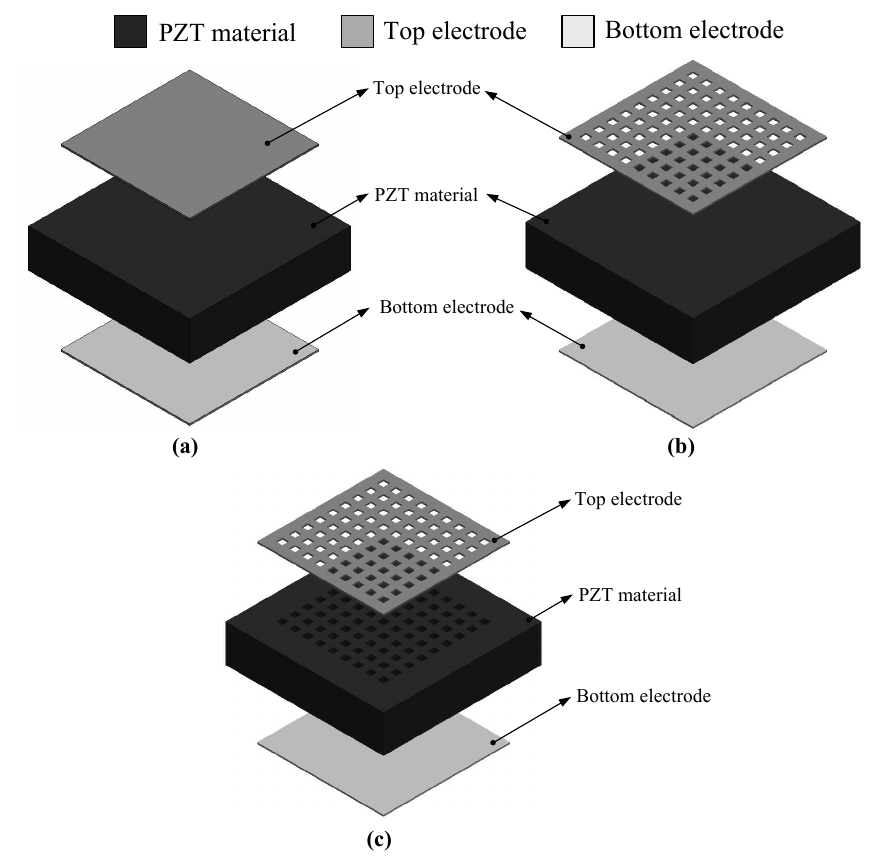
Figure 2. Schematic diagram of the PZT pyroelectric cells, ( a ) fully covered electrode,